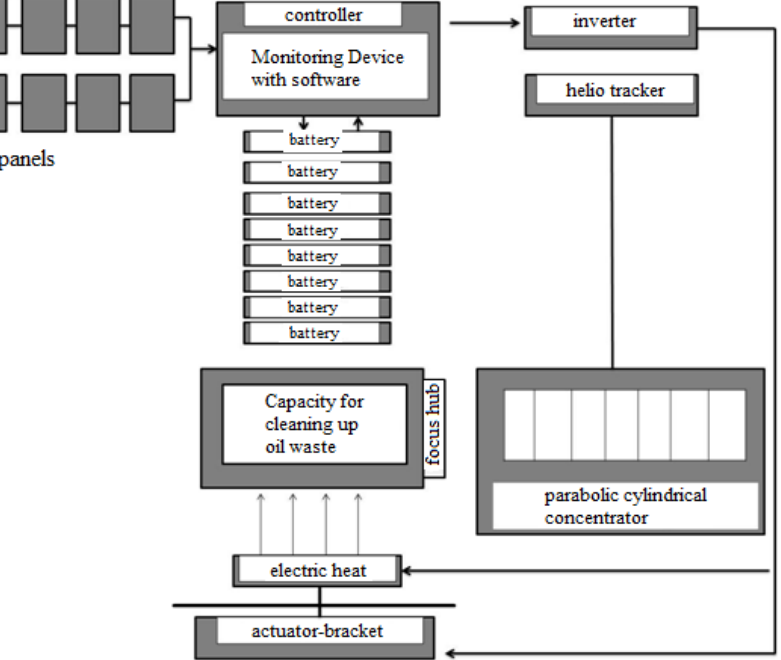
Fig. 1. Helio devices equipped with concentrating